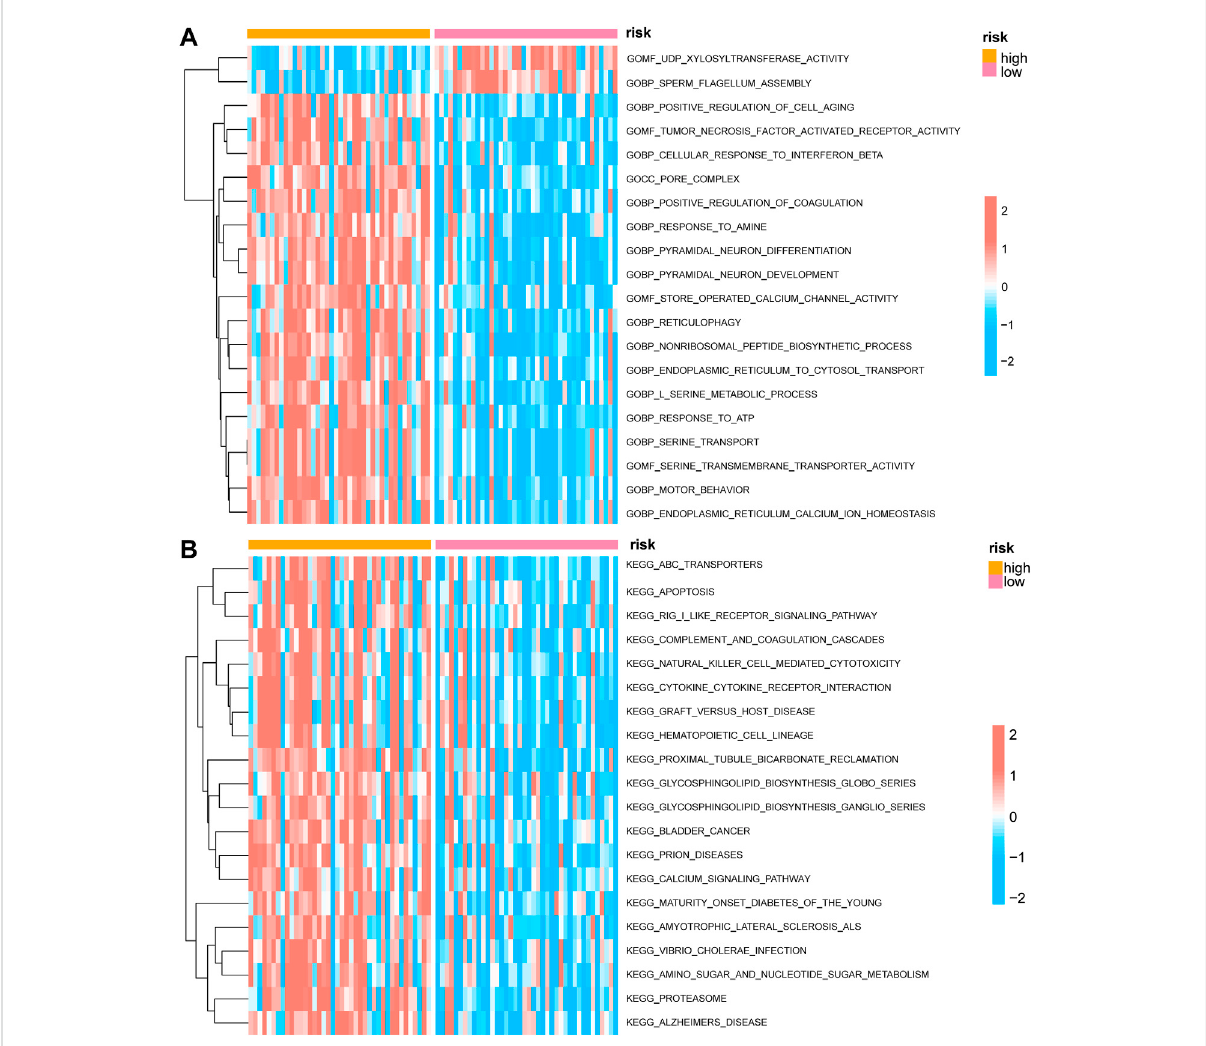
FIGURE 7 GSVA enrichment analysis between high and low prognostic risk groups. (A) Complex heat map showing the results of GSVA-GO analysis between low and high prognostic risk groups. (B) Complex heat map showing the results of GSVA-KEGG analysis between low and high prognostic risk groups. GSVA, gene set variation analysis; GO, gene ontology; KEGG, Kyoto Encyclopedia of Genes and